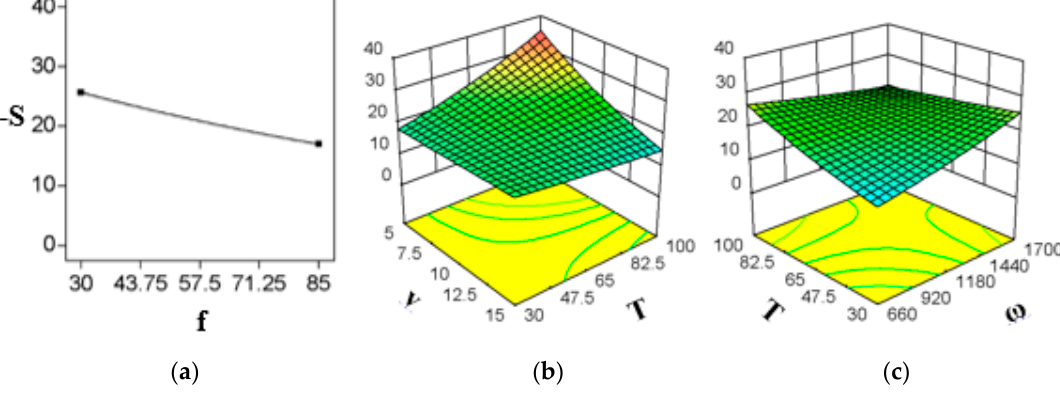
Figure 2. Significant parameters and interactions for composite’s Impact strength (I-S) ( a ) f (stand-alone parameter), ( b ) vT interaction, and ( c ) T ω interaction .